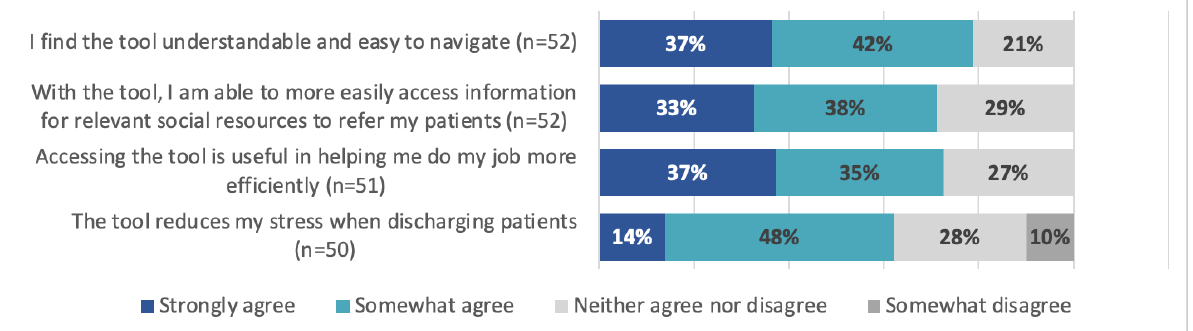
Figure 4. Impact of digital decision tool on clinician knowledge of and confidence in accessing homelessness and substance use resources.